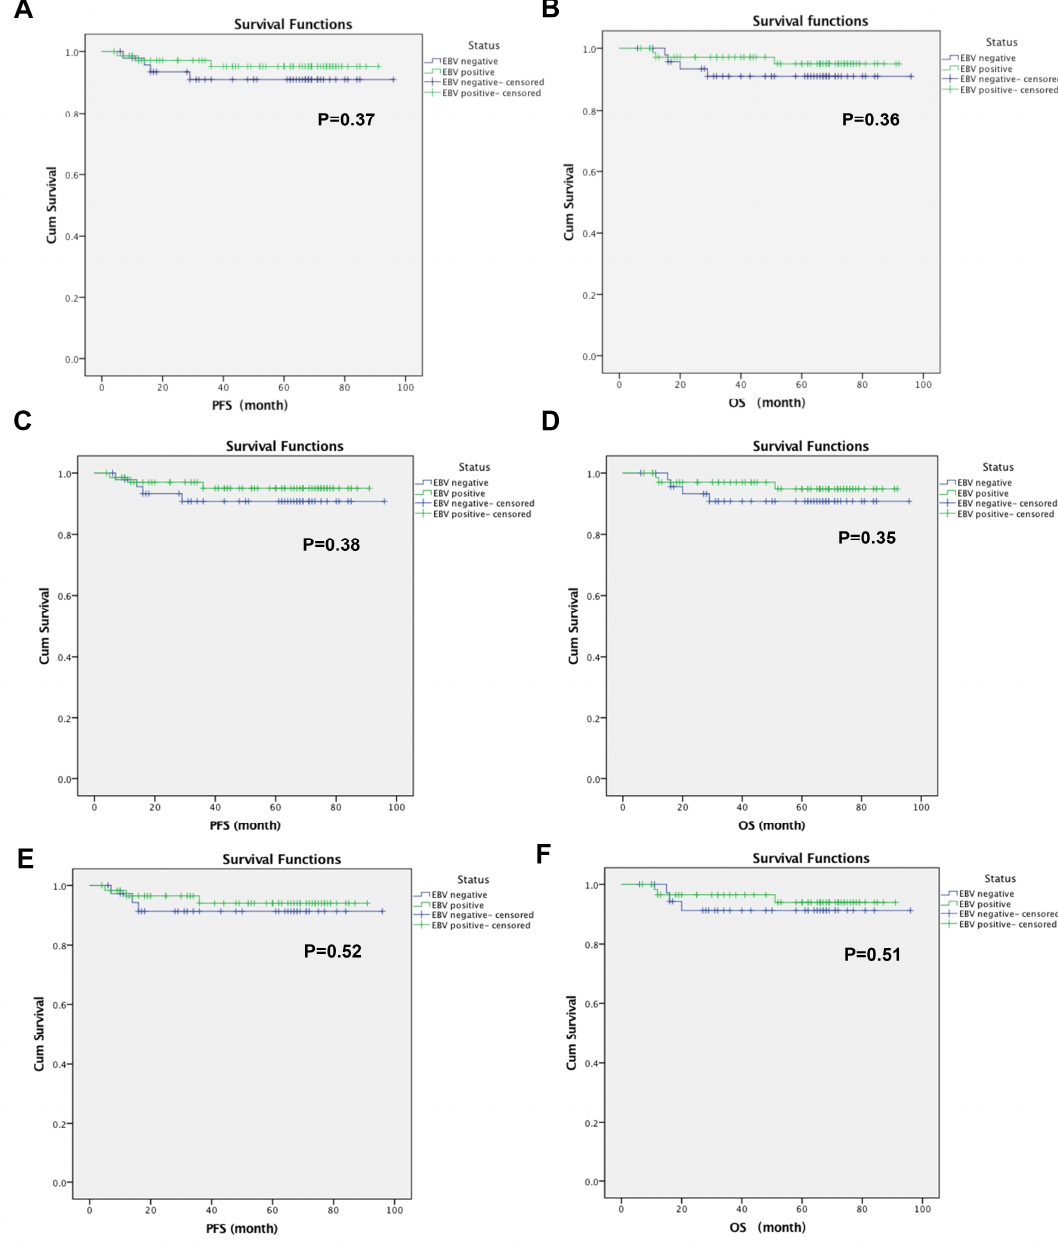
Figure 1. Impact of EBV status on survival of NPC patients. K–M plots of survival are shown for: ( A ) Cum survival of PFS, ( B ) Cum survival of OS in all stages of NPC patients; ( C ) Cum survival of PFS, ( D ) Cum survival of OS in stage II-IV NPC patients; ( E ) Cum survival of PFS, ( F ) Cum survival of OS in stage III-IV NPC patients. ( y -axis: cum survival percentage (%)). EBV: Epstein–Barr virus; NPC: nasopharyngeal carcinoma; PFS: progression-free survival; OS: overall survival.